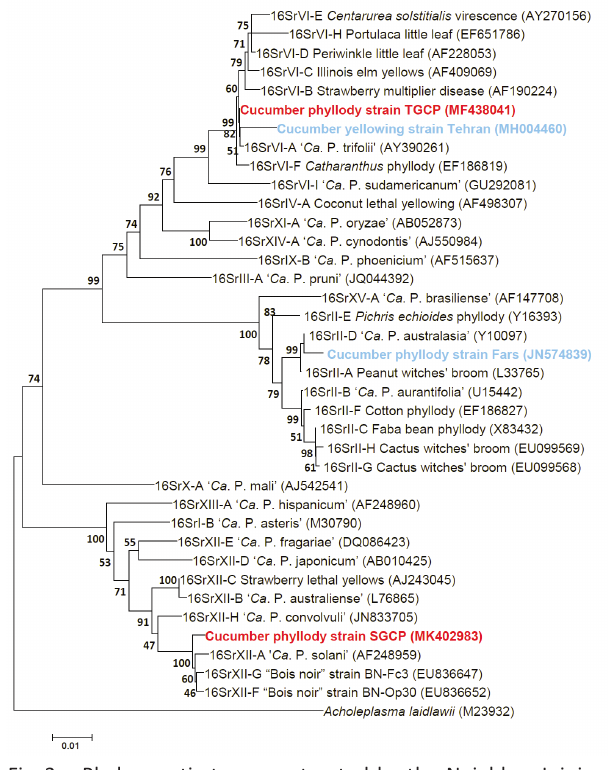
Fig. 3 ­ Phylogenetic tree constructed by the Neighbor­Joining method of the R16F2n/R16R2 sequence of 16S rRNA gene of 38 phytoplasmas including the cucumber strains SGCP, TGCP, Tehran and Fars, and phytoplasmas enclo­ sed in subgroups of the 16SrVI, 16SrII and 16SXII groups. The greenhouse cucumber phyllody phytoplasmas are in color and bolded (in red those sequenced in this